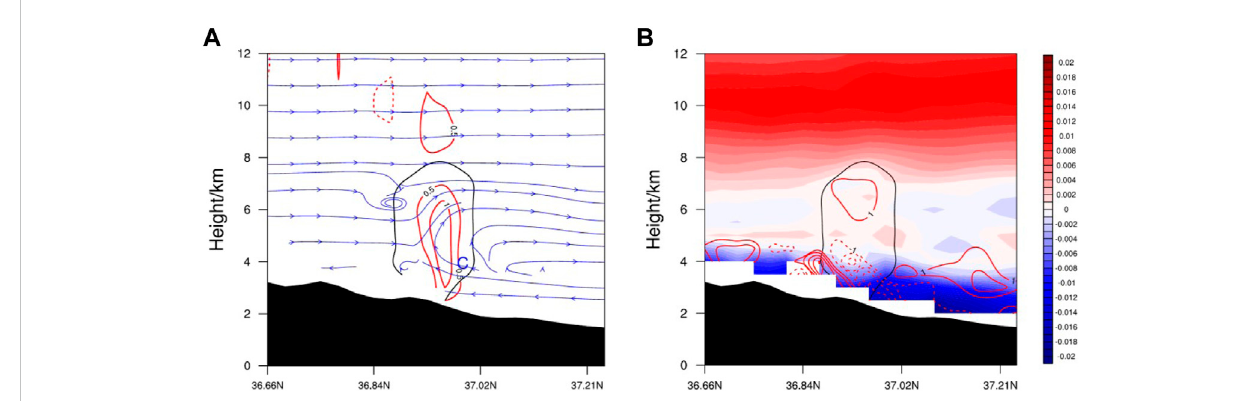
FIGURE 8 Crosssectionsof (A) theverticalvelocity(redcontours,units:m s − 1 )andstreamlines, (B) atmosphericstrati fi cationstability(shadings,units:km − 1 )and